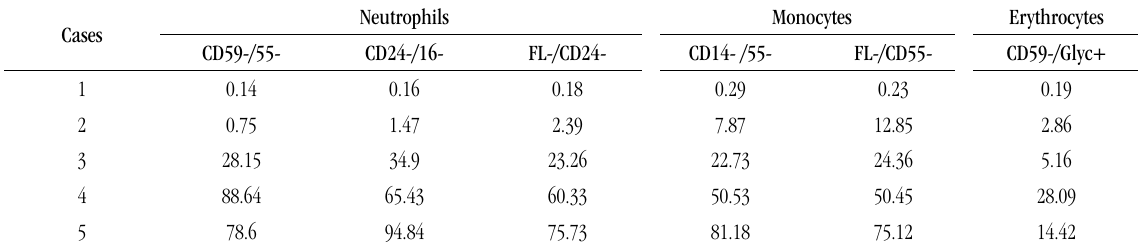
tABLE 3 – Proportions of GPI-deficient cells detected in positive samples for the presence of the clone, by reagent combinations, in the three studied cell populations. Results expressed in percentage value (%)